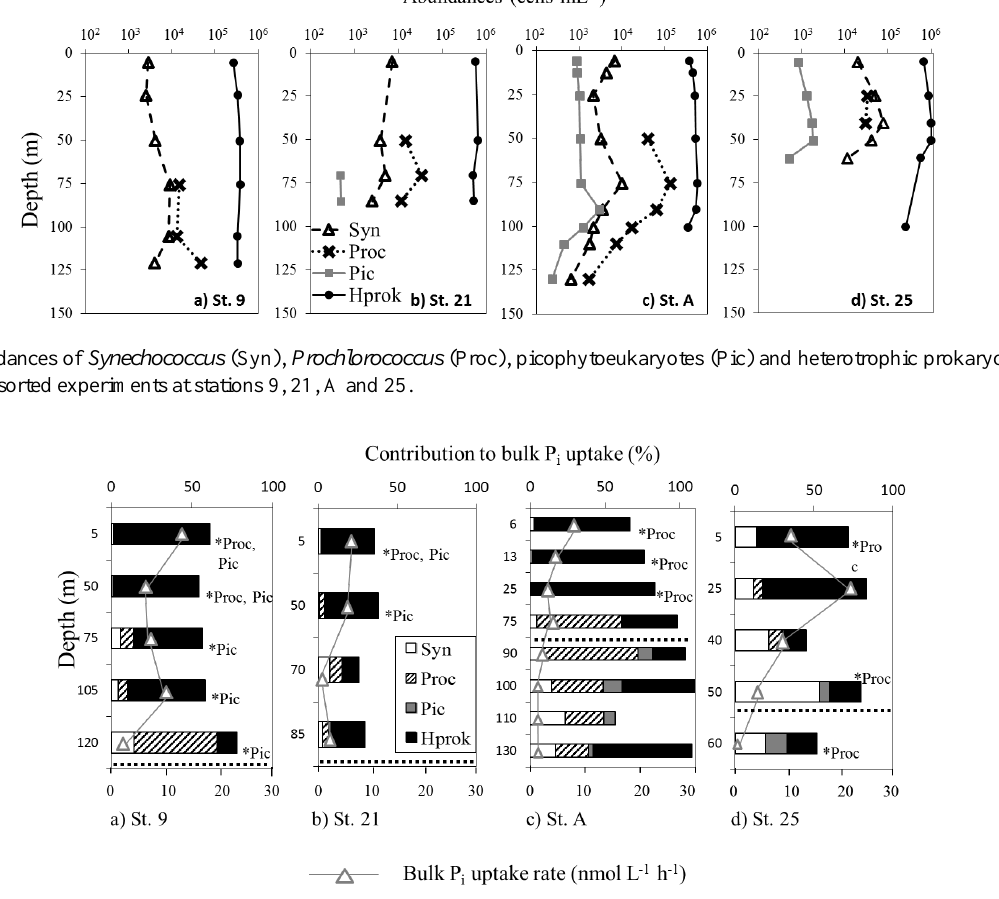
Figure 4. Cumulated contributions of picoplankton groups (superimposed bars for Synechococcus , Syn; Prochlorococcus , Proc; picophy- toeukaryotes, Pic; heterotrophic prokaryotes, Hprok) to the bulk Pi uptake (upper scale, 100% = measured bulk Pi uptake rate) and bulk Pi uptake rates (lower scale, white triangles) along the euphotic water column at stations 9, 21, A and 25. Dotted horizontal lines mark the deep chlorophyll maximum depth. Please note the different vertical scales. Missing groups are specified with an asterisk